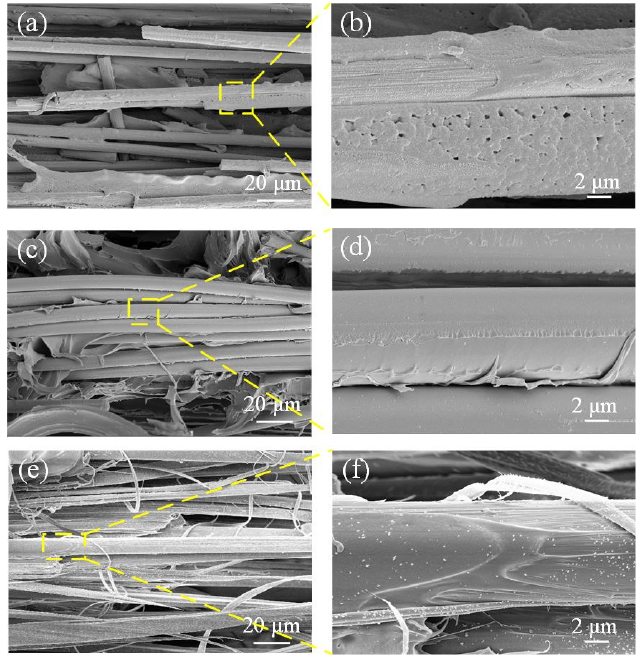
Figure 9. SEM micrographs of three kinds of fibers after composites are broken after tensile: ( a , b ) carbon fiber, ( c , d ) glass fiber, ( e , f ) Kevlar